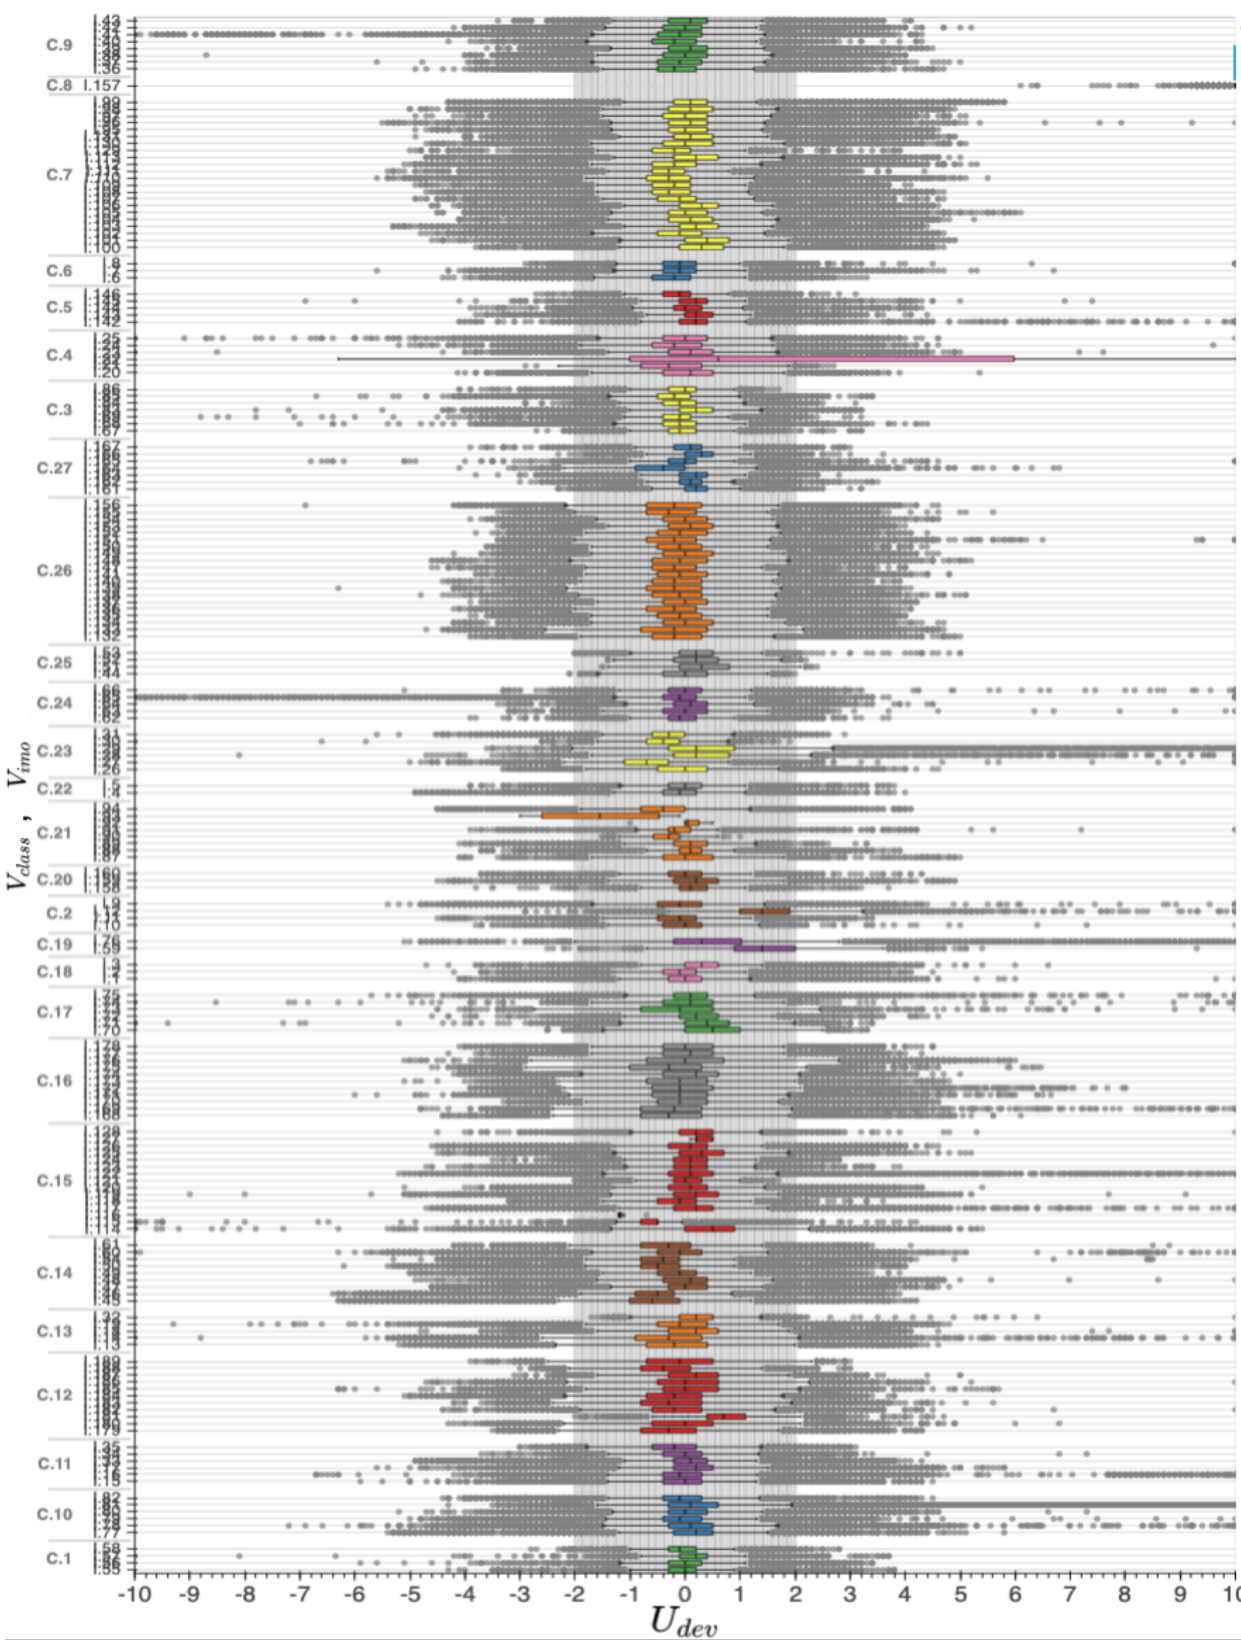
Figure 8. Boxplot of U dev by vessel class V class and IMO number V imo